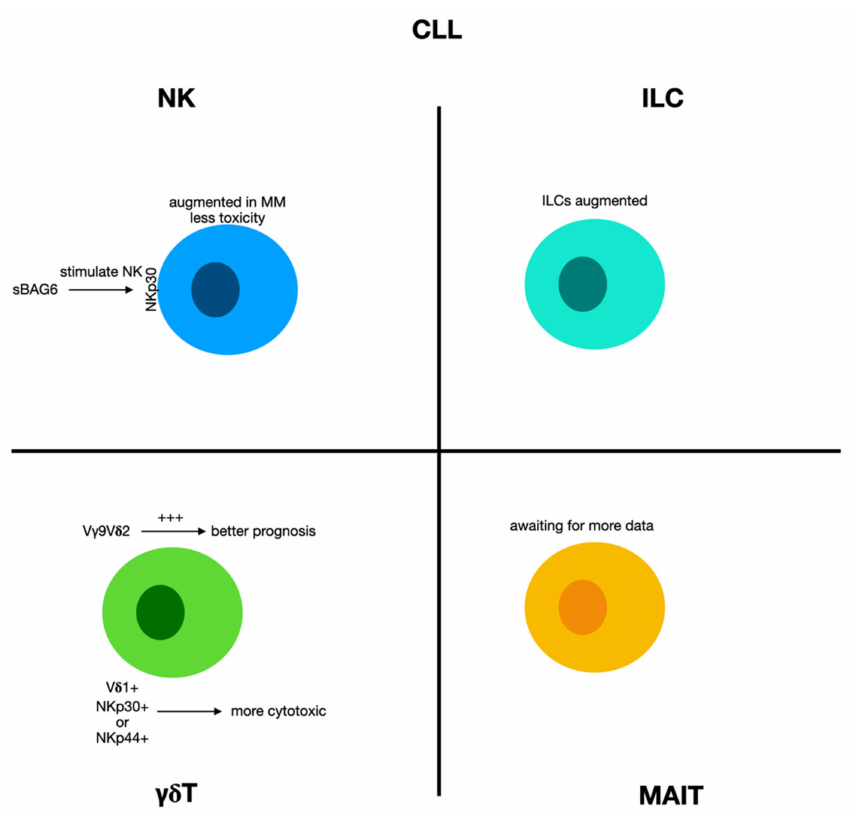
Figure 6. Chronic lymphocytic leukemia (CLL) unconventional immune cell scenario. NK: NKs are augmented but with less toxicity. Soluble BAG6 (i.e., NKp30-ligand) can stimulate NK cells via NKp30. ILC: ILCs are augmented. γδ T: the increase in V γ 9V δ 2 tumor-infiltrating T cells was correlated with a favorable prognosis in CLL. V δ 1 cells that present NCRs could kill CLL cells via NKp30 and